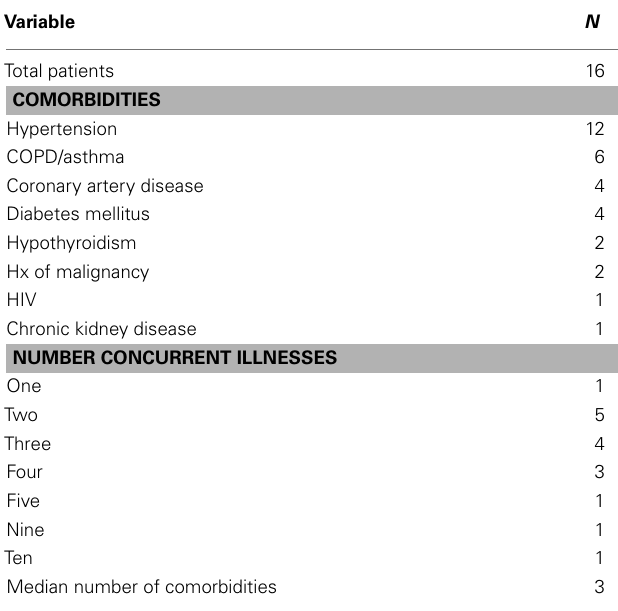
Table 1 | Patient and disease characteristics . Table 2 | Incidence of medical comorbidities